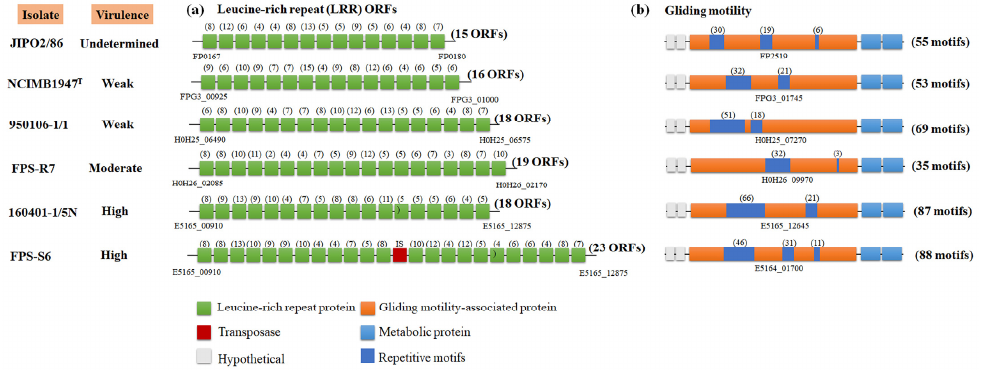
Figure 4. Schematic distribution of repetitive genetic regions in F. psychrophilum isolates. ( a ) Localization of leucine-rich repeats identified by hybrid assembly of Illumina and PacBio sequencing technologies. ( b ) Representative amino acid repeat units in gliding motility-associated protein. Genes are represented as squares. Loci tags, isolates, and virulence phenotype are shown in the figure to facilitate comparison. The number of repetitive motifs is presented in parenthesis and their amino acid sequences are described in the Table S4.